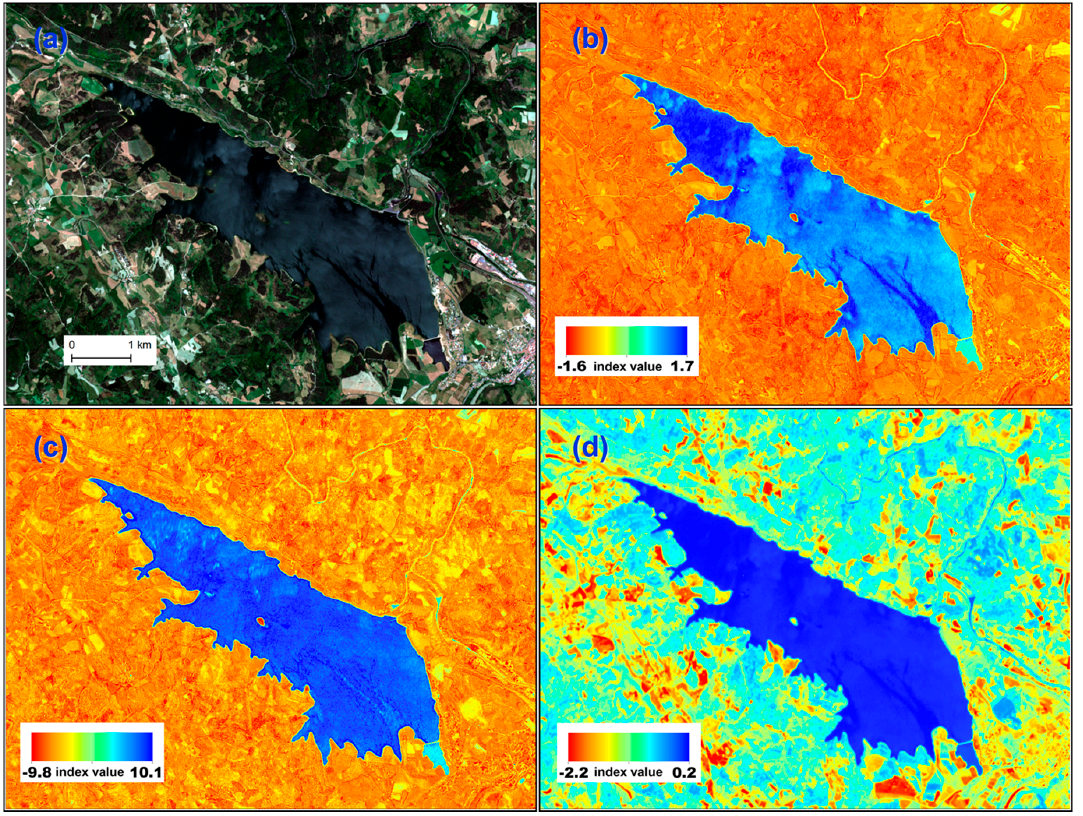
Figure 2. Sentinel-2 RGB image ( a ) over Naussac reservoir (altitude: 940 m) in France and maps of index values of MuWI-R ( b ), MuWI-C ( c ), and AWEI nsh ( d ) with minimum and maximum index values.